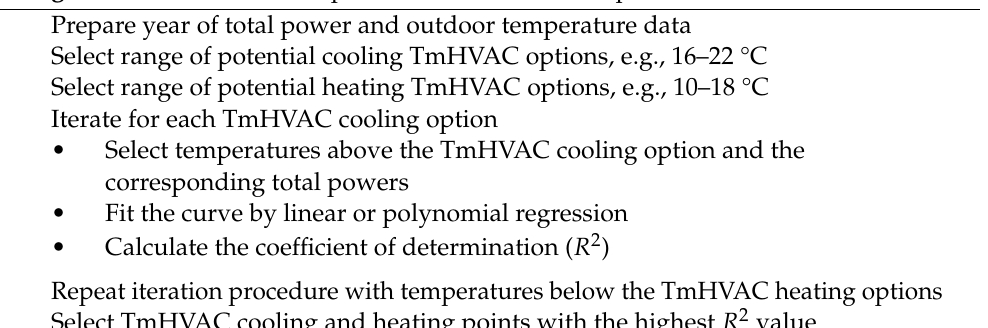
Algorithm 1: Mathematical process for TmHVAC temperature